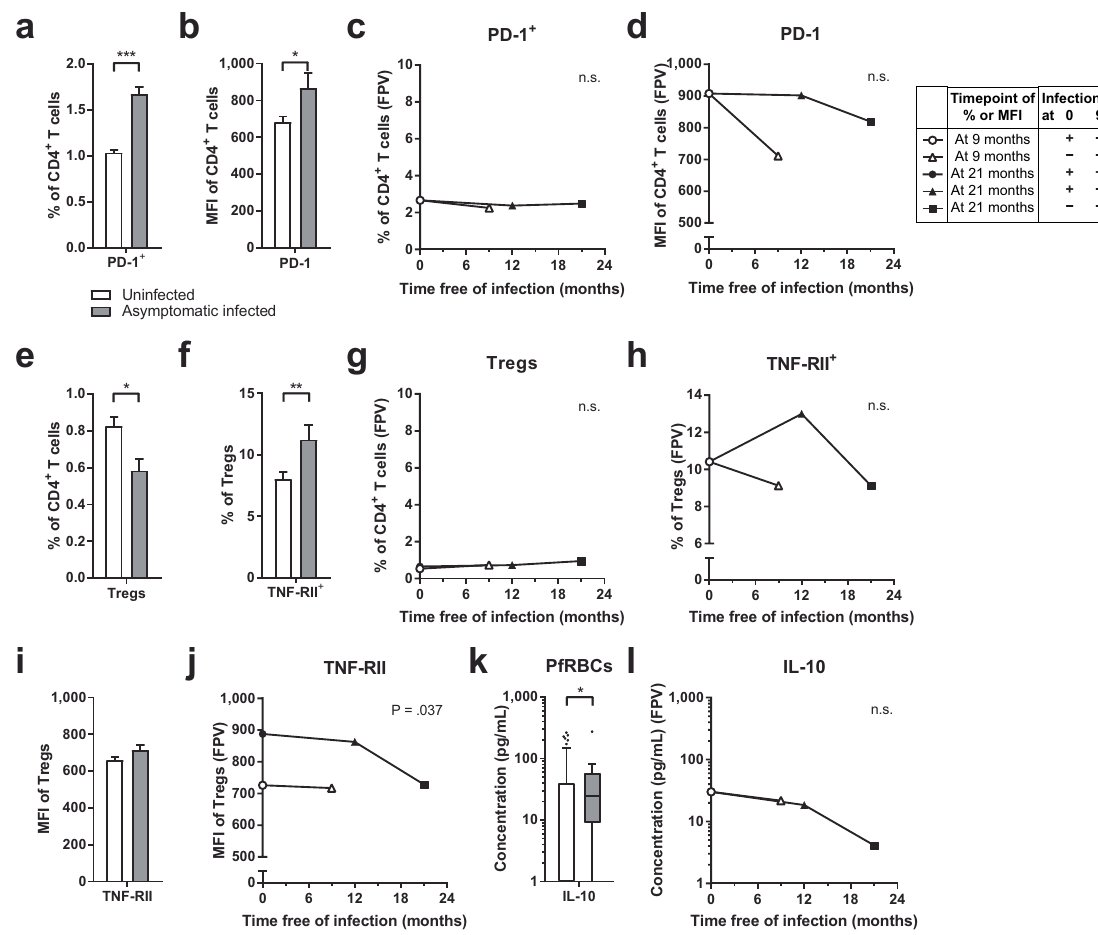
Figure 2. Profiles of PD-1 + CD4 + T cells and Tregs and IL-10 production. ( a , b , e , f , i ) The percentage of cells or the expression level of markers on cells compared between uninfected and asymptomatic infected children at baseline. The expression levels are based on geomean fluorescent intensities (MFI). Bar graphs show means and standard errors of the mean. ( c , d , g , h , j ) The percentage of cells or the expression level of markers on cells in children uninfected at either the 9 or 21 months’ time point, plotted against the time period these children had been free of infection (see description Fig. 1). ( k ) IL-10 cytokine production by PBMCs in supernatant in response to in vitro PfRBC stimulation, after background subtraction of responses to uninfected RBC. l) IL-10 cytokine production in children uninfected at either the 9 or 21 months’ time point, plotted against the time period these children had been